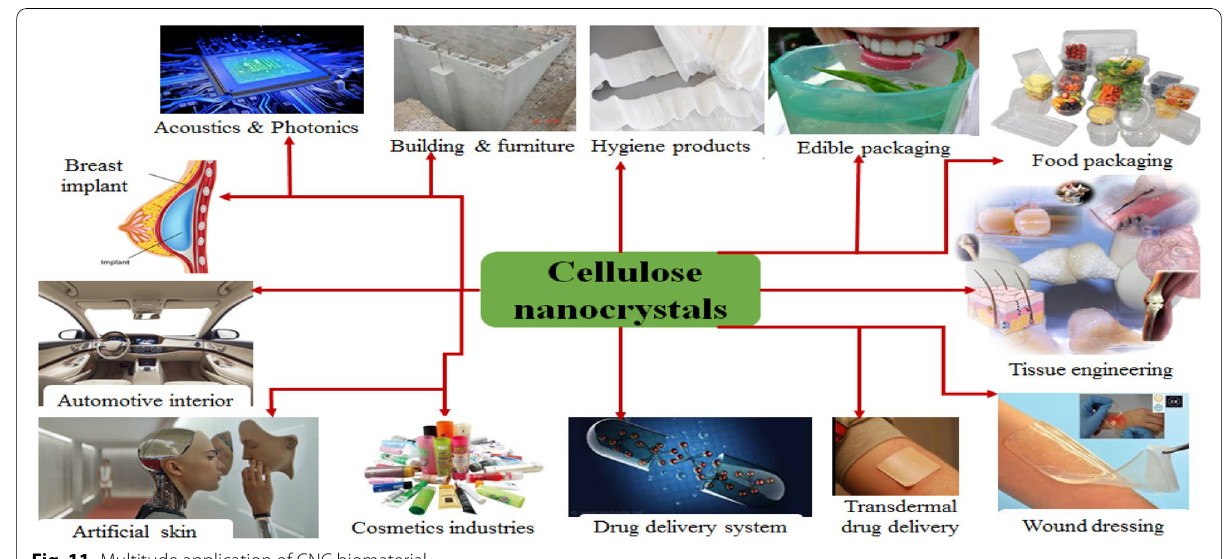
Fig. 11 Multitude application of CNC